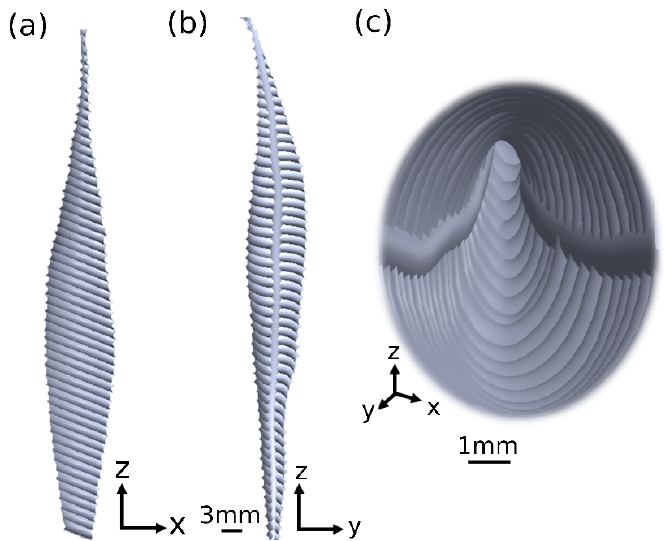
Figure 1. Female canal model and uterine cavity model. ( a ) 3D female tract geometrical model. Projections of the 3D geometrical model in the ‘x–z’ plane ( b ) and ‘y–z’ plane ( c ).